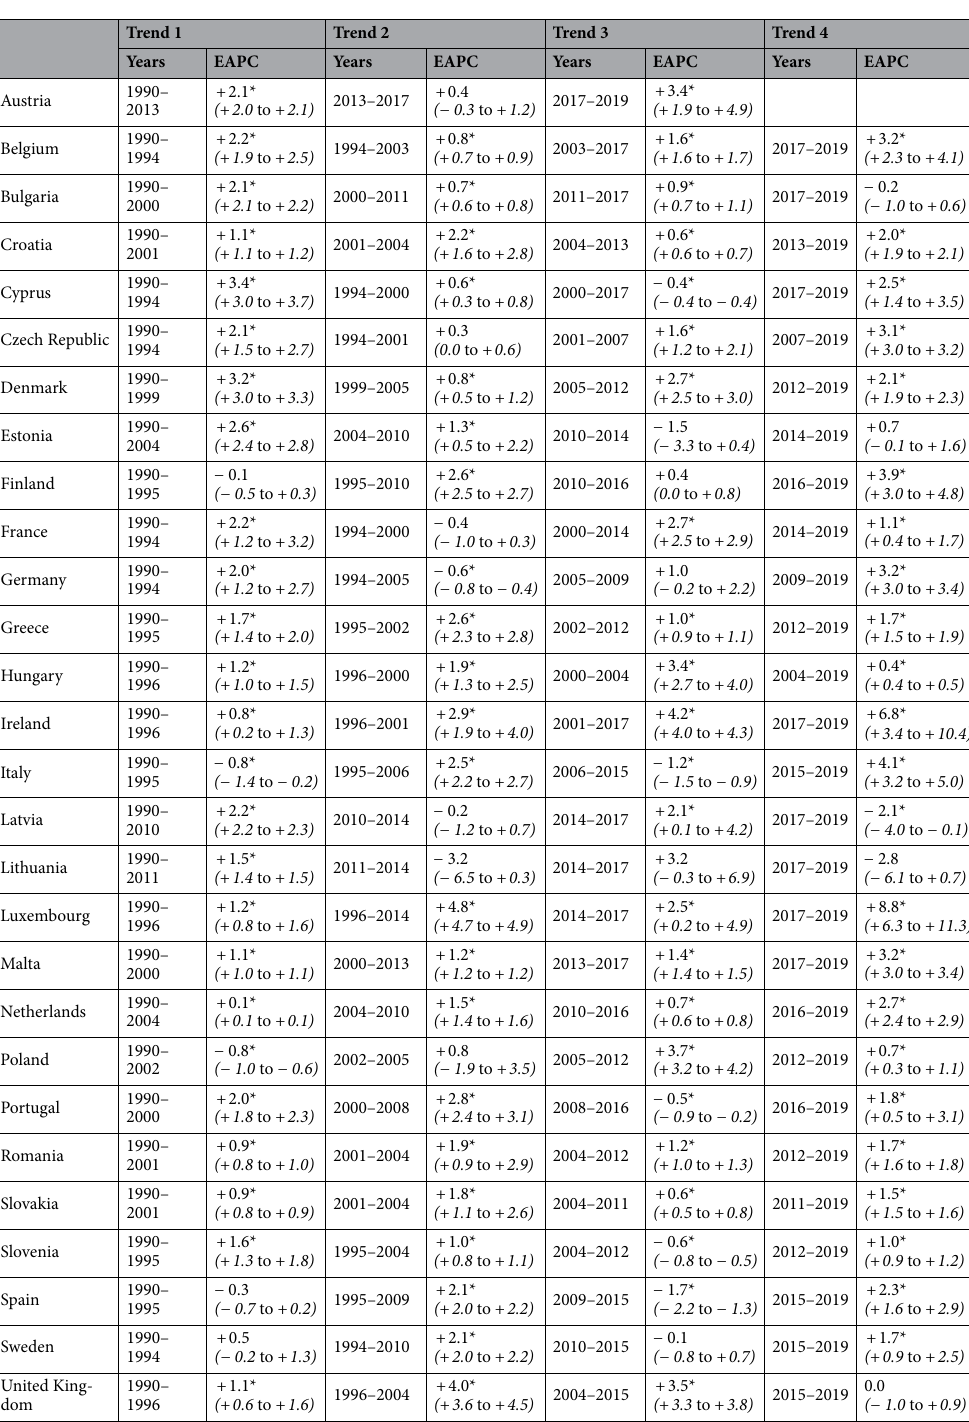
Table 4. Joinpoint analysis for age-standardised prevalence rates (ASPRs) per 100,000 population for type 2 diabetes (T2DM) in females. Italic values indicates 95% confidence intervals. Data presented as estimated annual percentage change (EAPC %), with 95% confidence intervals in brackets. P values deemed significant if <